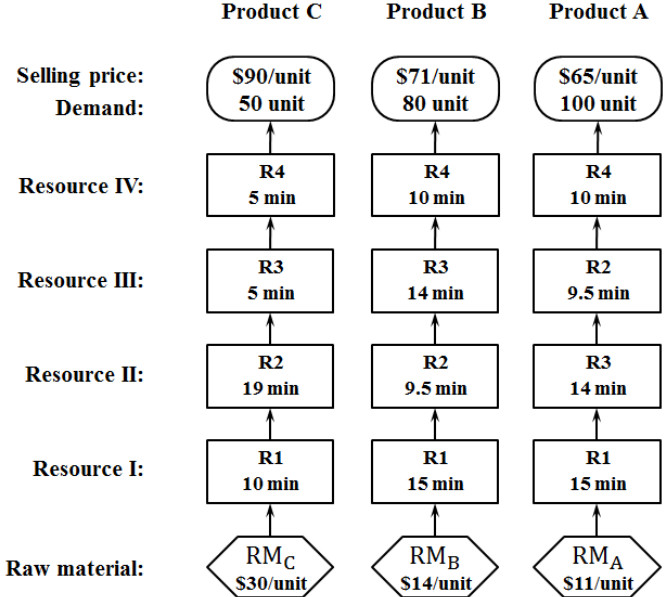
Fig. 3. Data for product mix problem